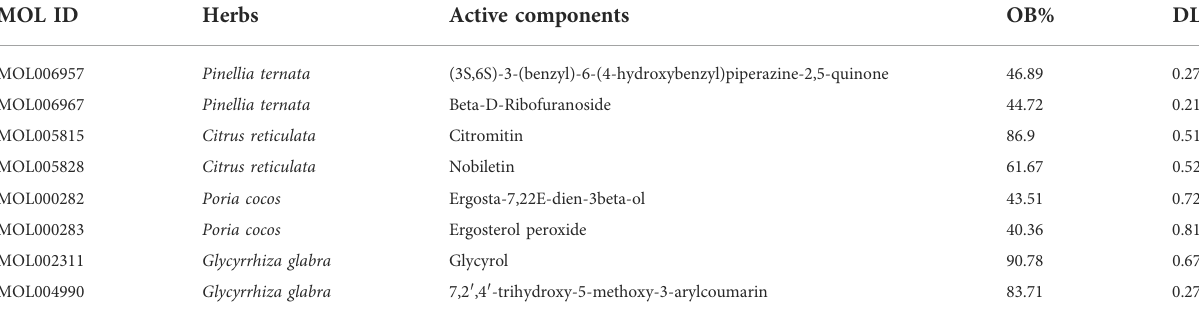
TABLE 1 Top 2 active components with OB value of each herb in